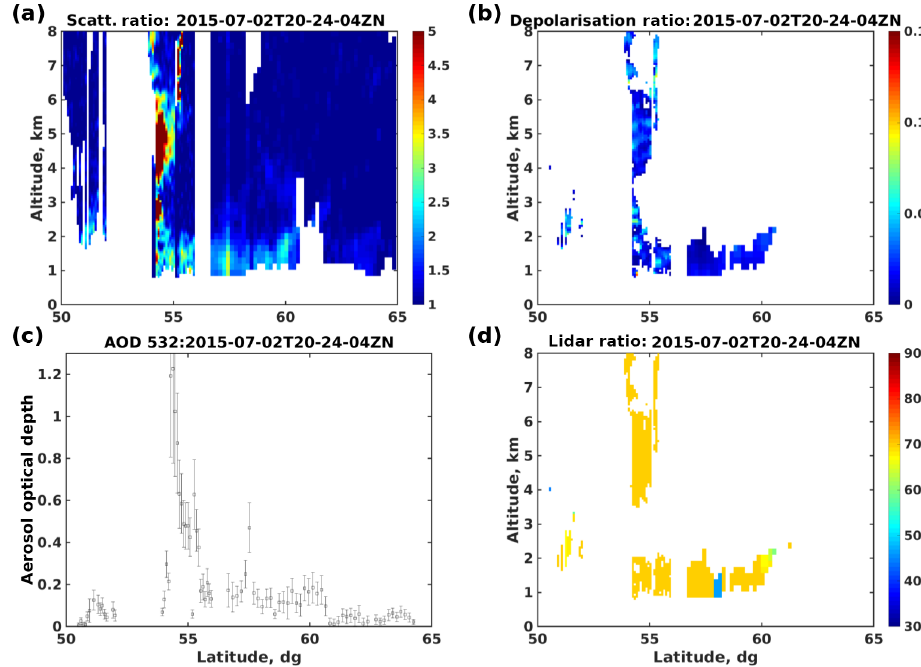
Figure 15. Same as Fig. 14 for 2 July 2015.